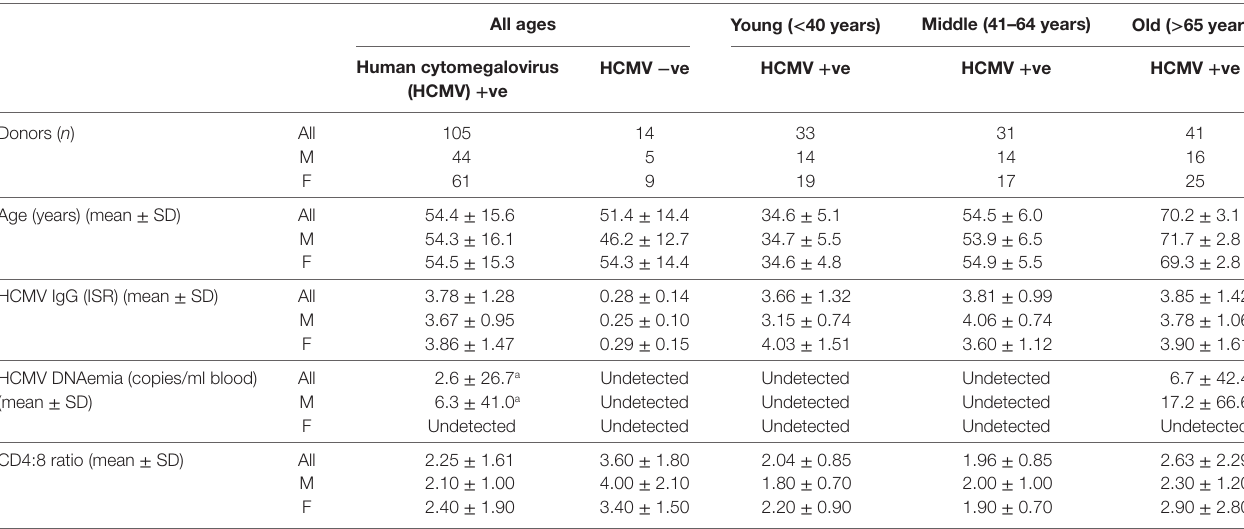
TaBle 1 | ARIA cohort donor characteristics.